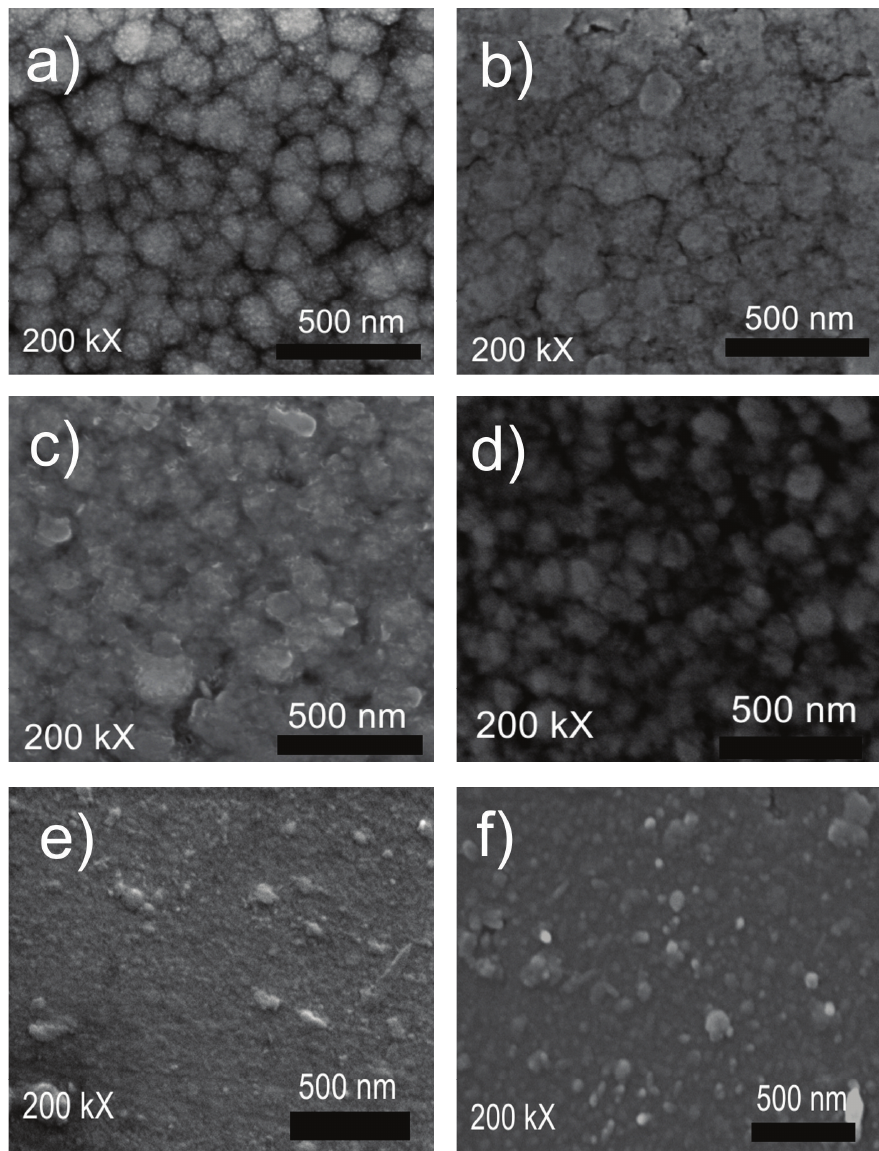
Figure 1: SEM images of the chalcogenides studied (a) and (b) Zn 𝑥 Cd 1−𝑥 S, (c) and (d) Cu 𝑥 Cd 1−𝑥 S, and (e) and (f) Cu 𝑥 Zn 1−𝑥 S annealed at 250 ∘ C ((a), (c), and (e)) and 450 ∘ ((b), (d), and (f)), respectively.